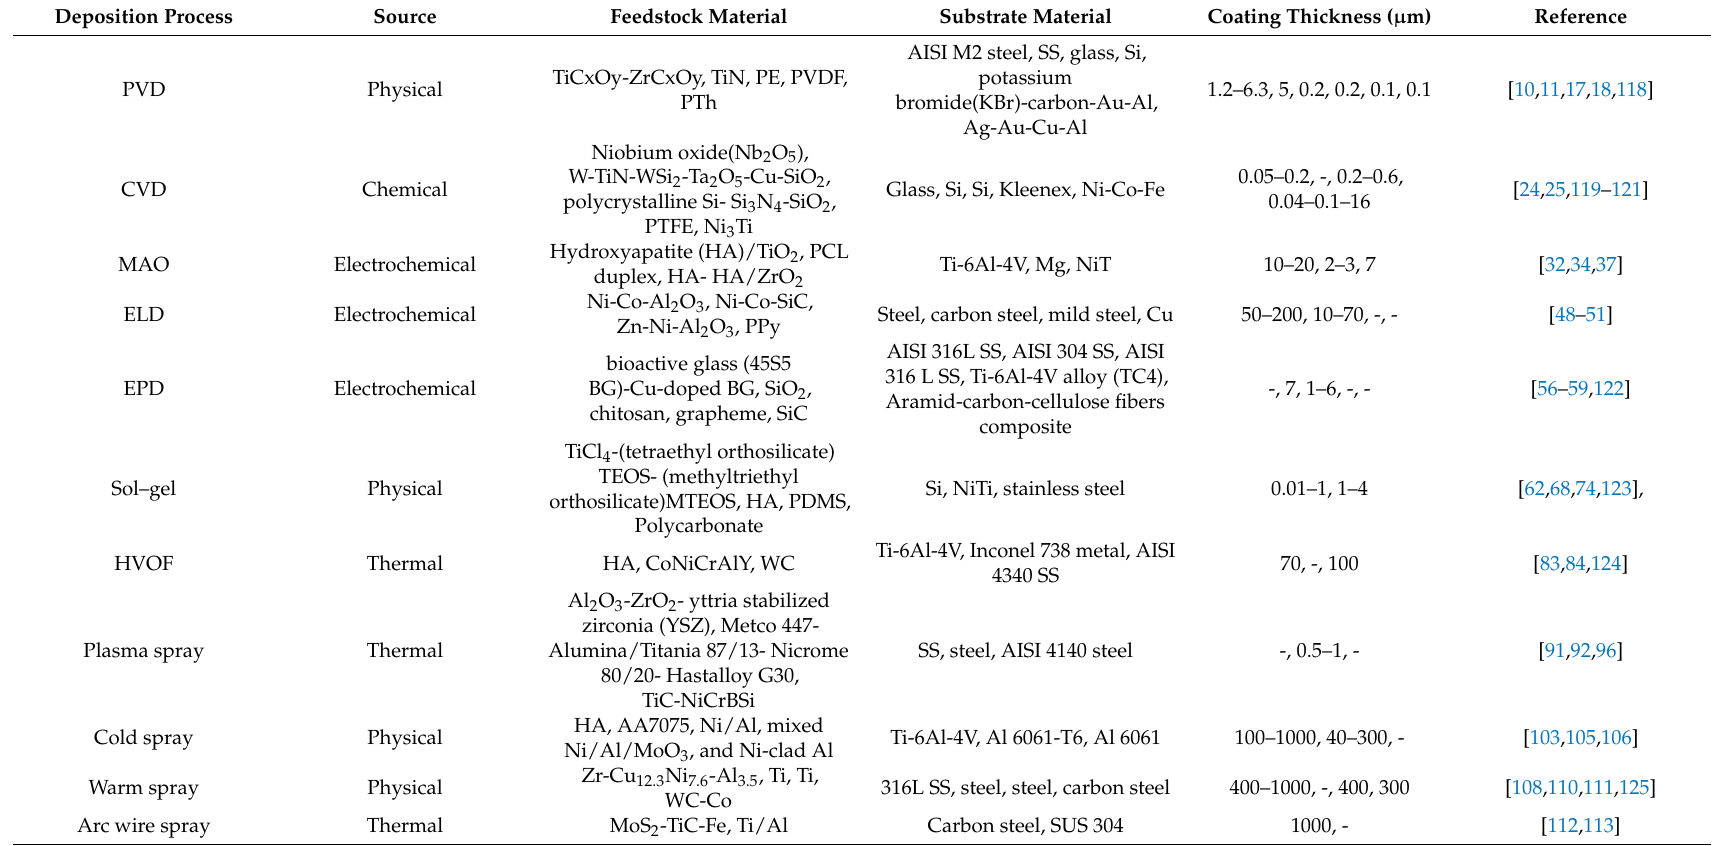
Table 3. Summary of coating processes and their specific